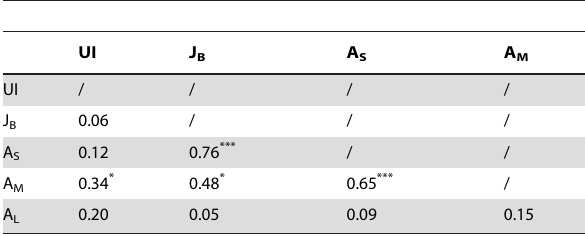
Table 1. Correlation coefficients regarding R. stricta densities in 21 m square plots between different R. stricta size classes (assumed different